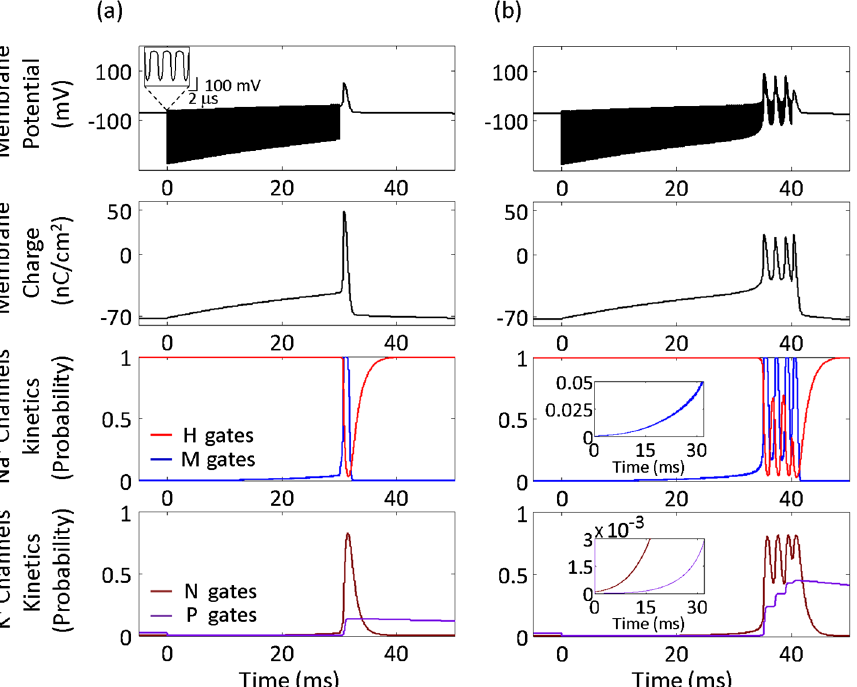
FIG. 2 (color online). The effect of continuous US stimuli (frequency 0.35 MHz, intensity 320 mW = cm 2 ) on membrane potential & charge (top panels), and on sodium and potassium channels kinetics (bottom). (a) For stimulus duration of 30 ms, a single AP is generated immediately after the stimulus ends. Inset shows membrane potential oscillations. (b) For a stimulus duration of 40 ms, four APs are generated during the stimulus. Insets: magnified view of open probabilities for the M gate (Na þ channel kinetics) and the N and P gates (K þ